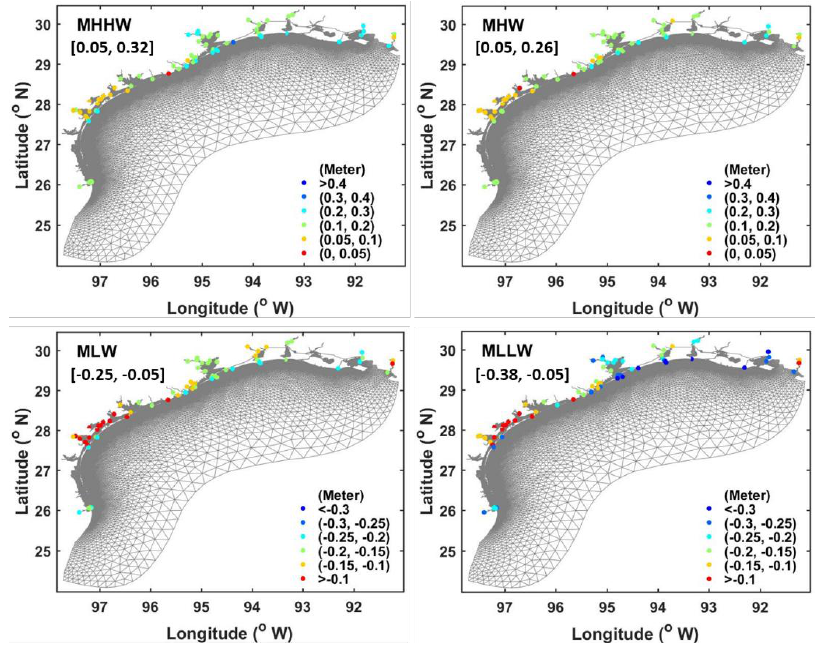
Figure 5. Observed tidal datums with minimum and maximum values listed in the brackets.